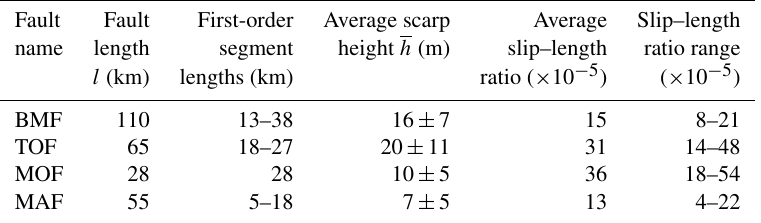
Table 3. Slip–length ratios for southern Malawi faults: Bilila–Mtakataka (BMF), Thyolo (TOF), Muona (MOF) and Malombe (MAF). Fault